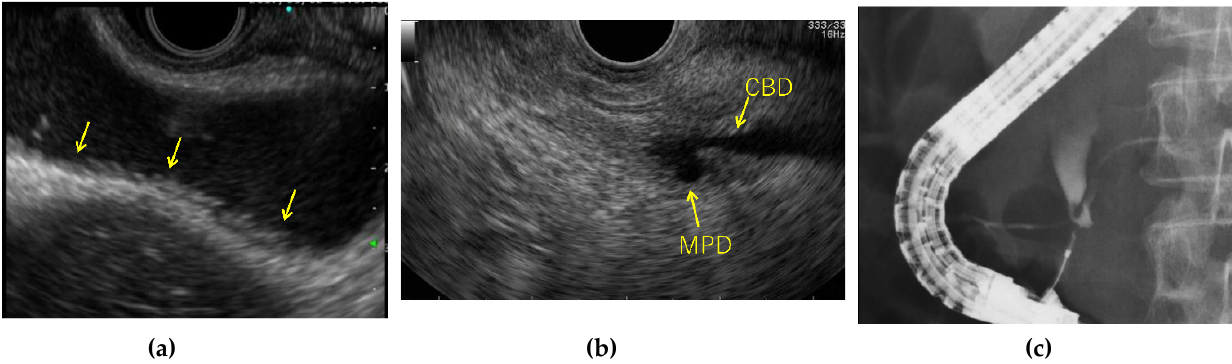
Figure 4. Pancreaticobiliary maljunction with gallbladder wall thickening. ( a ) Endoscopic ultrasonography (EUS): Diffuse low papillary-shaped elevated lesion in the gallbladder (arrow). ( b ) Endoscopic ultrasonography: Pancreaticobiliary duct junction in the pancreatic parenchyma. CBD; common hepatic duct, MPD; main pancreatic duct ( c ) ERP: Findings of the pancreatic duct junction-type maljunction.